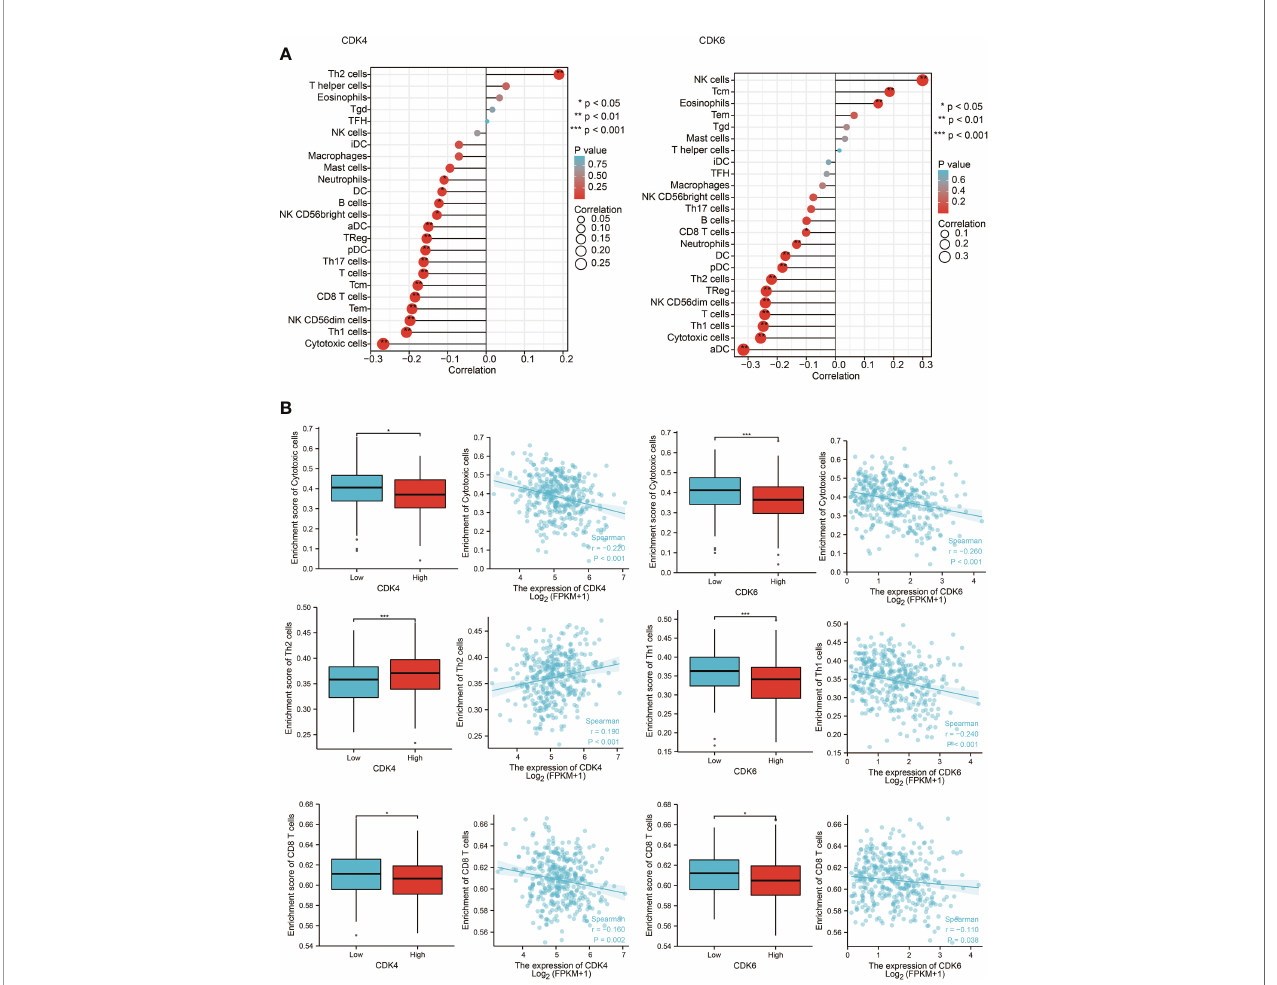
FIGURE 3 | The correlation between CDK4/6 expression and tumor-in fi ltrating immune cells. (A) Correlation between the relative abundances of 24 immune cells and CDK4/6 expression level. The size of dots shows the absolute value of Spearman R. (B) Scatter plots and correlation diagrams showing the difference of cytotoxic cells, Th1/2 cells, and CD8 + T cells in fi ltration level between CDK4/6-high and CDK4/6-low